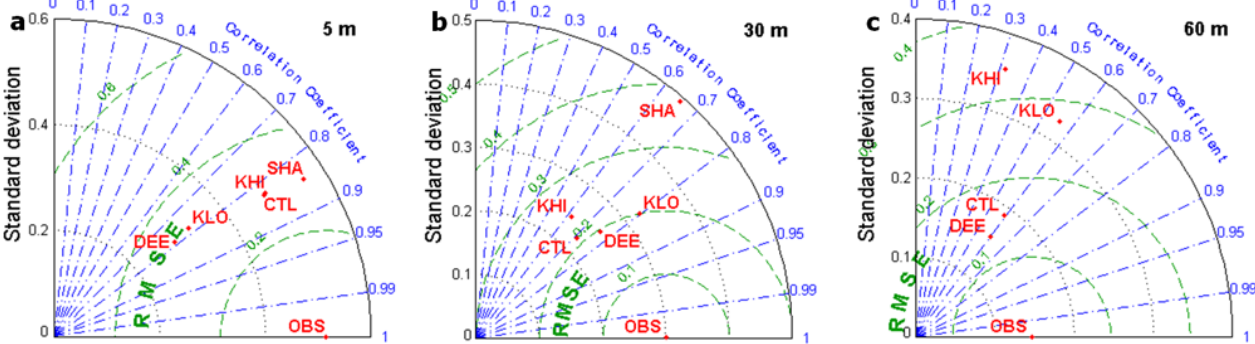
Fig. 10. Taylor diagram indicating model performance for water temperature at (a) 5m, (b) 30m and (c) 60m depths for different external parameter values at Ishungu (January 2003–December 2011). Standard deviation σ T ( ◦ C; radial distance), centred root mean square error RMSE c ( ◦ C; distance apart) and Pearson correlation coefficient r (azimuthal position of the simulation field) were calculated from the observed T-profile interpolated to a regular grid (1m increment) and corresponding midday FLake profile. OBS: observations, CTL: control, SHA (DEE): model lake depth set to and 30m (120m), KHI (KLO): downward light attenuation coefficient k set to the highest (lowest) observed value at Ishungu. Note that model performance indicators at 60 m cannot be calculated for the SHA